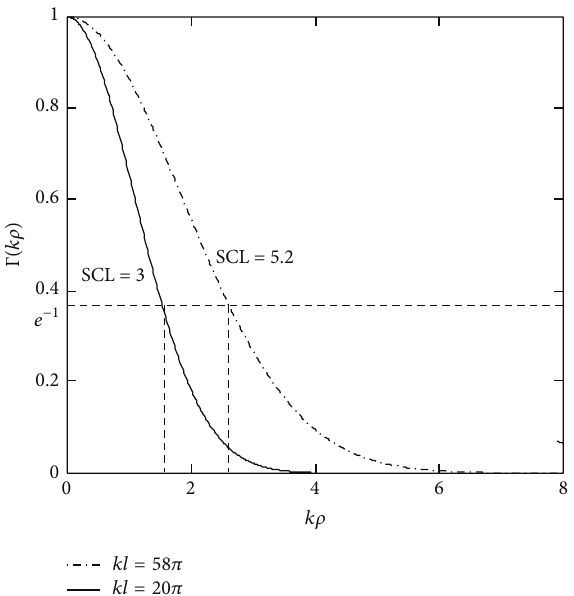
Figure 2: The degree of spatial coherence of an incident wave about the